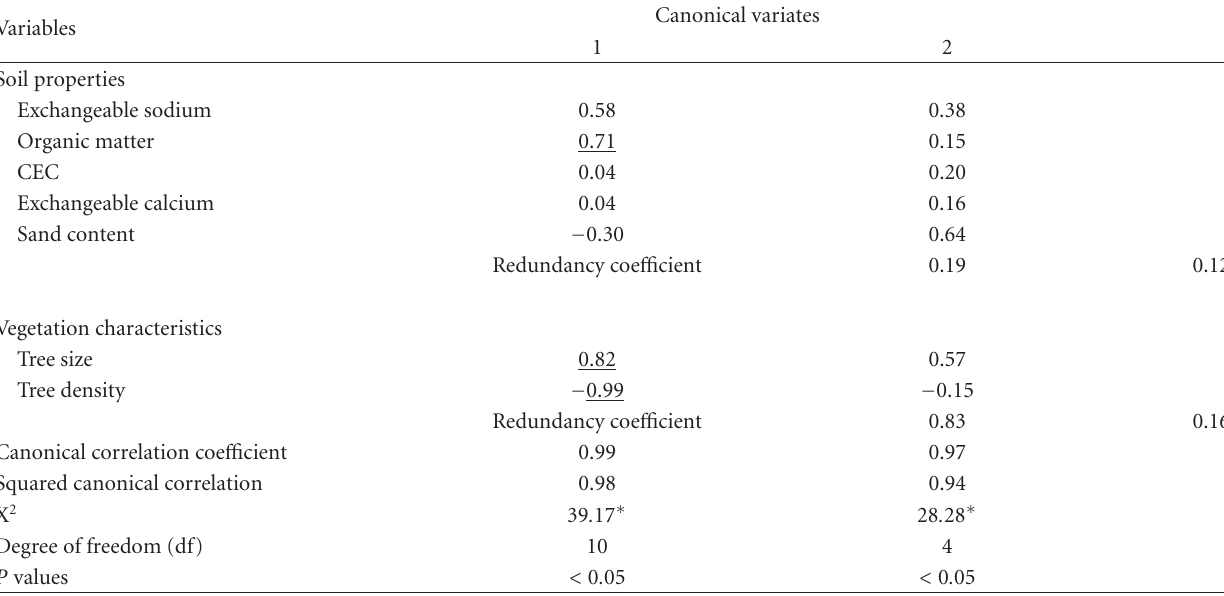
Table 5: Result of canonical correlation analysis of relationships between soil and vegetation a